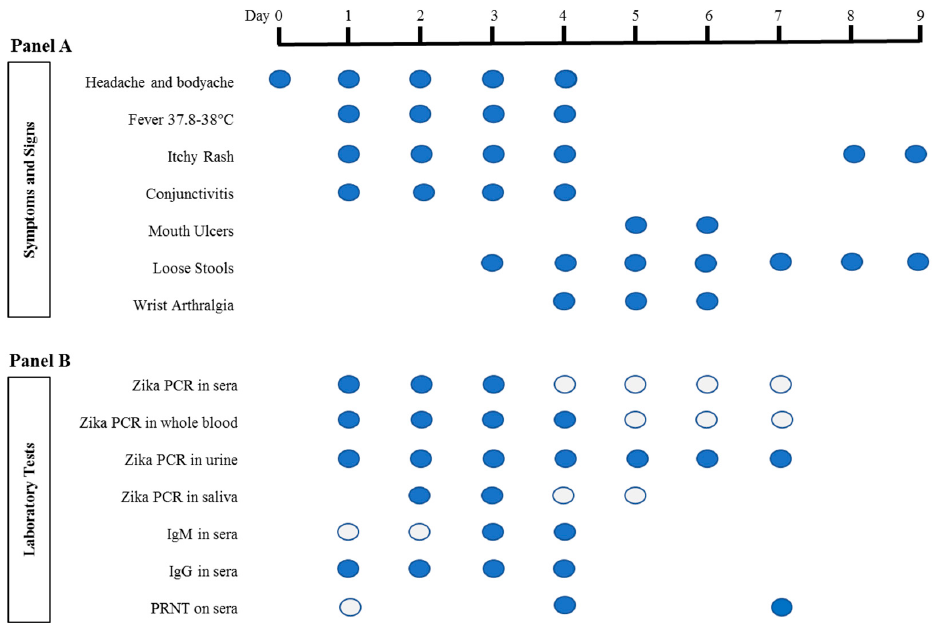
Figure 1. Summary of symptoms, signs, and laboratory test results. For Panel A, represents the presence of symptoms and signs on any particular day. For Panel B laboratory tests, each circle represents a sample that was tested. represents negative, while represents positive results.